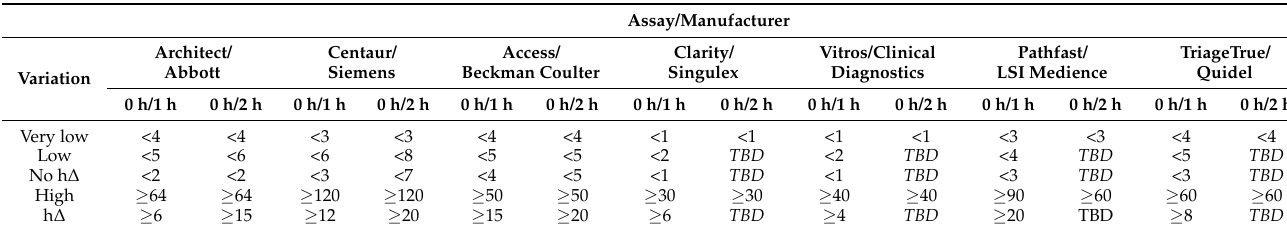
Table 4. Troponin I assay specific cut-off levels in the rule-in or rule-out 0 h/1 h and 0 h/2 h algorithms in NSTEMI diagnosis; values are expressed in ng/l; adapted from